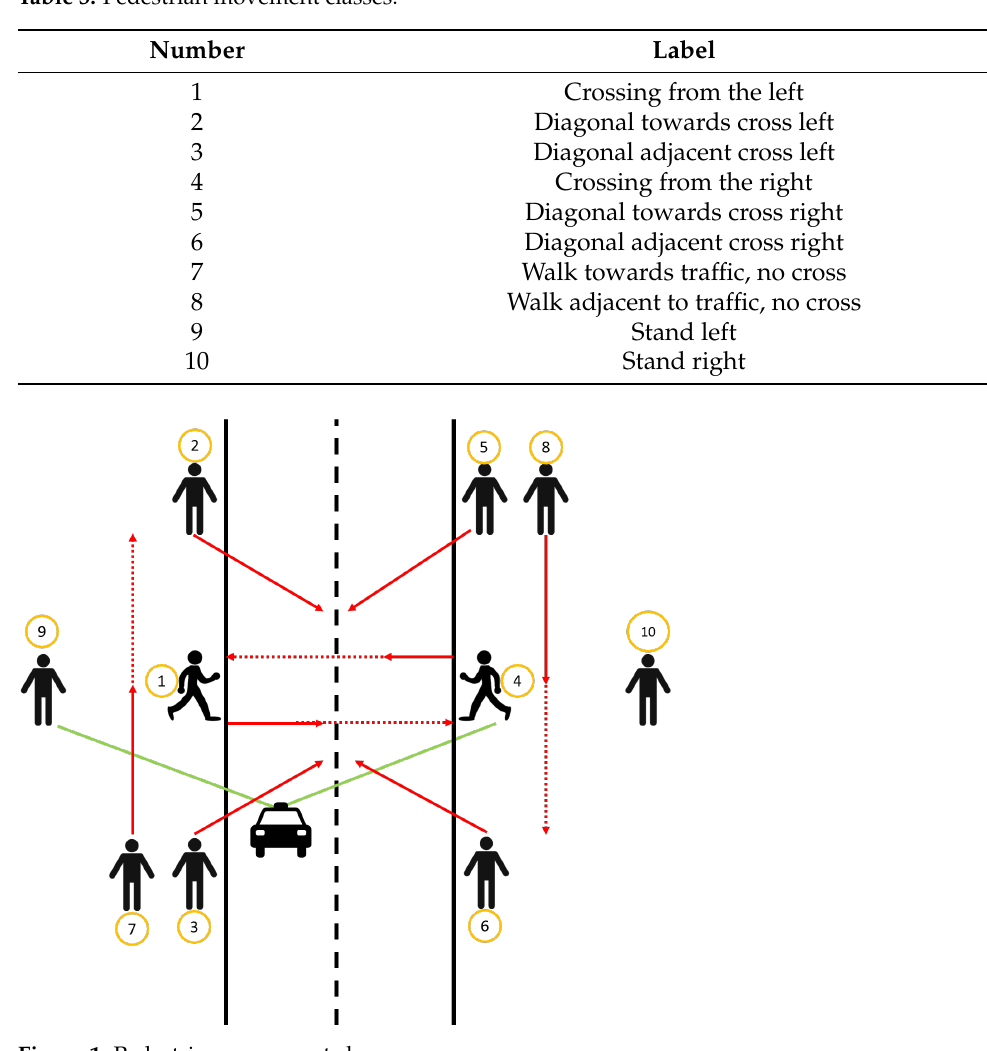
Table 3. Pedestrian movement classes.